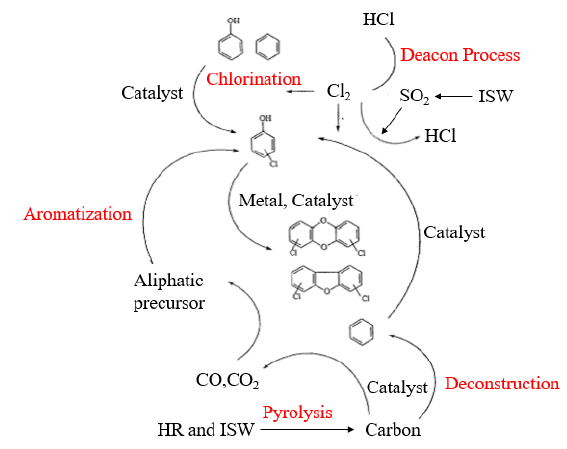
Figure 6. Pyrolysis dioxin formation model diagram. Table 7. Reaction of sulfur with key elements in the synthesis of dioxin.